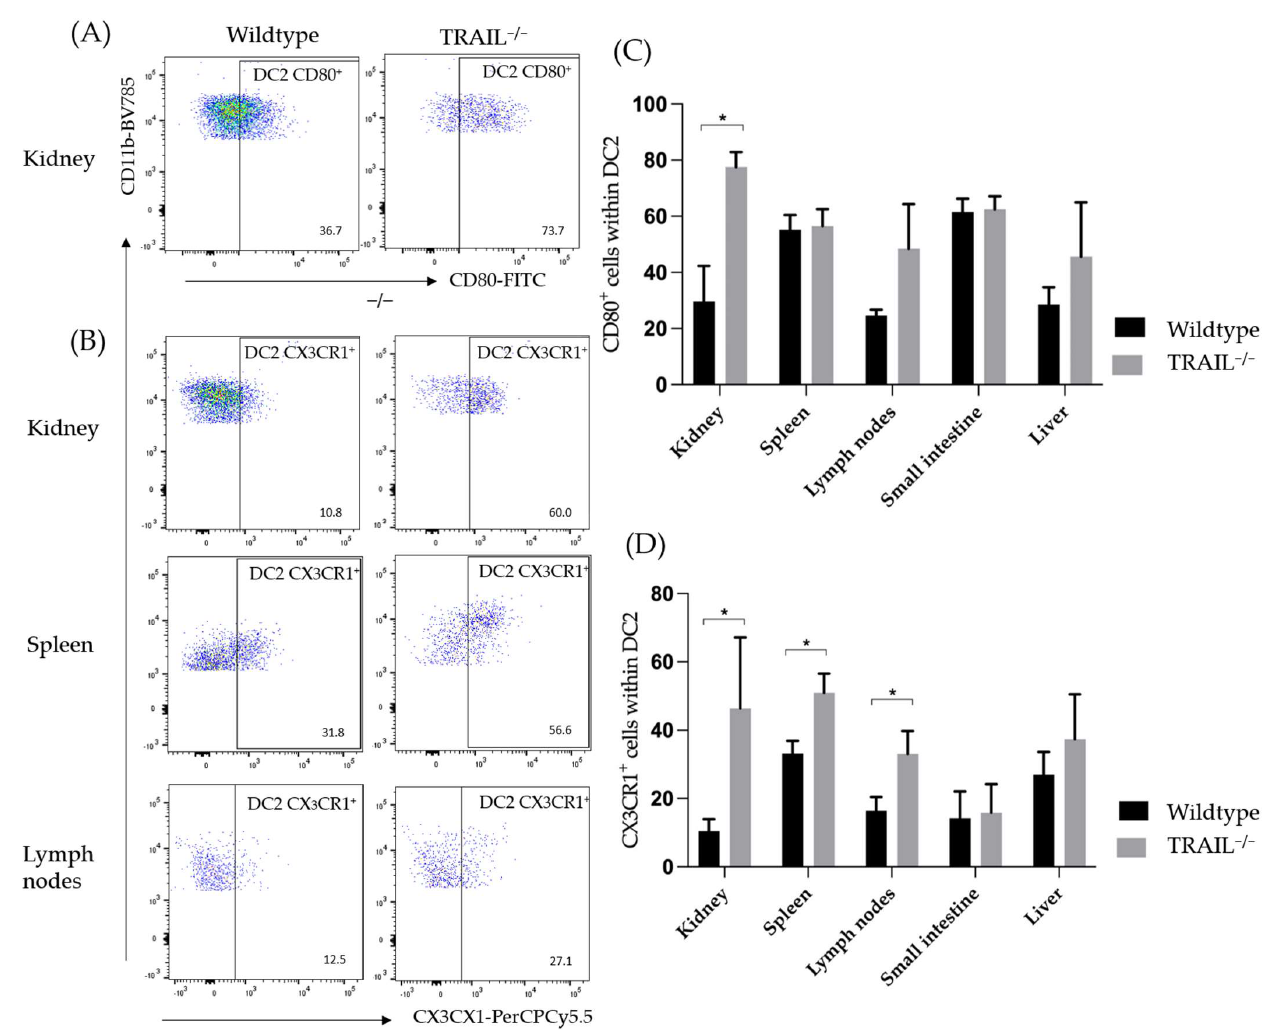
Figure 2. Distribution of CD80 + ( A ) and CX 3 CR1 + ( B ) CD11c + MHCII + DCs in the kidney, spleen, lymph nodes, small intestines, and liver of TRAIL −/− mice versus wildtype C57BL/6 mice. ( A , B ) Exemplary dot plot illustrate the CD80 ( A ) and CX 3 CR1 ( B ) expression on CD11c + MHCII + dendritic cells in the kidney, spleen, and lymph nodes of a TRAIL −/− mice. ( C , D ) Histogram compares means ± SEM of all CD80 + ( C ), CX 3 CR1 + and ( D ) CD11c + MHCII + DCs in kidney, spleen, lymph nodes, intestine, and liver (( C , D ) t -test, n = 6 per group, * p <